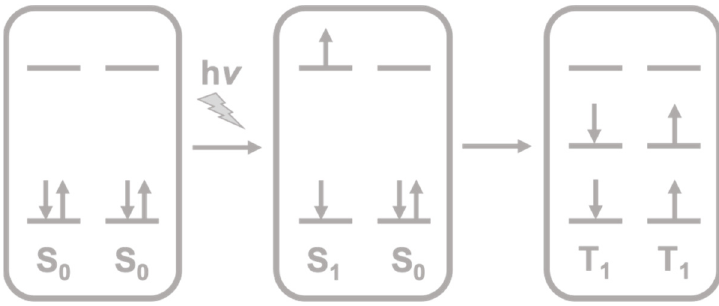
Figure 1. Schematic representation of the singlet fission process.